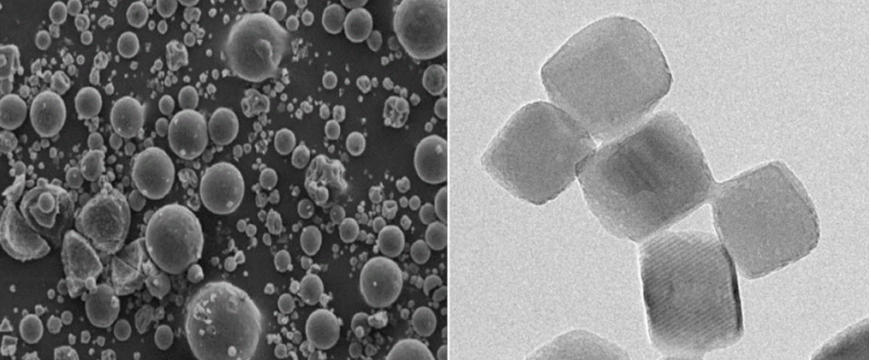
Figure 4. The presentation of nanometer calcium carbonate prepared from